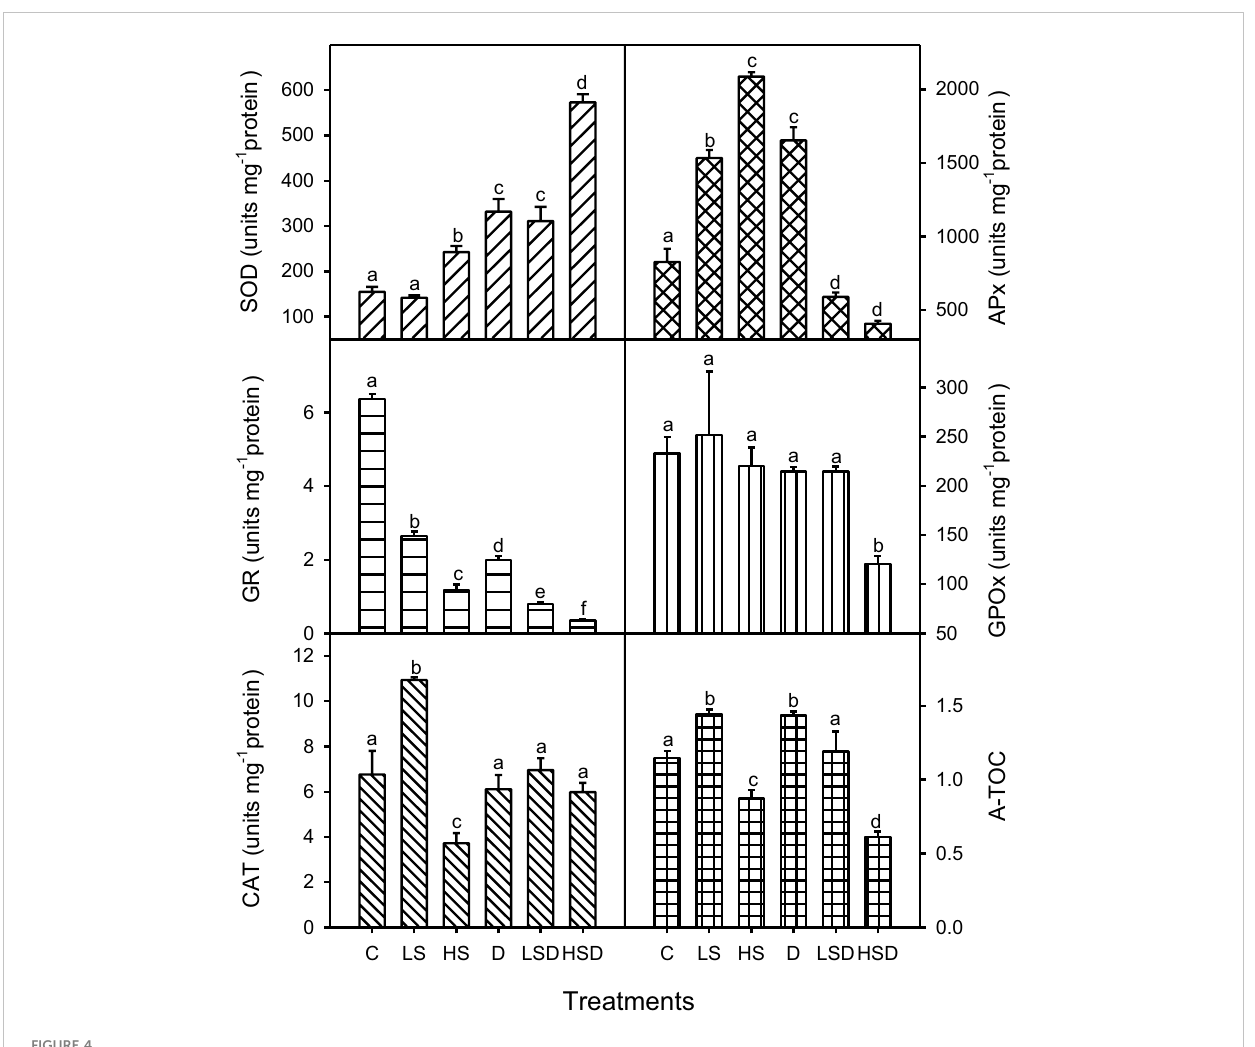
FIGURE 4 Antioxidant enzymes (SOD: superoxide dismutase, APx: ascorbate peroxidase, GR: glutathione reductase,GPOX: guaiacol peroxidase and CAT: catalase and total antioxidant capacity of Panicum antidotale under salt (0, 100, 300 mM NaCl; abbreviated as C, LS and HS respectively), drought (D) and combination of both (abbreviated as LSD and HSD). The values represent the means and ± S. E (n = 3) where n is number of plants sampled from different pots. After the Bonferroni post hoc test, different letters denote signi fi cant difference at P <